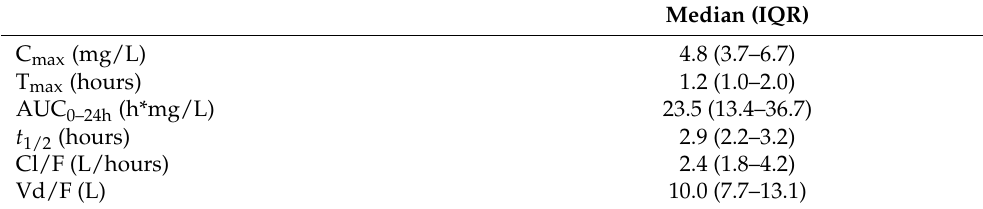
Table 2. Summary of estimated pharmacokinetic parameters of 23 assessments in 20 infants; 3 patients on preventive therapy were sampled twice, before and after 3 months of age. All data shown as median (interquartile range).